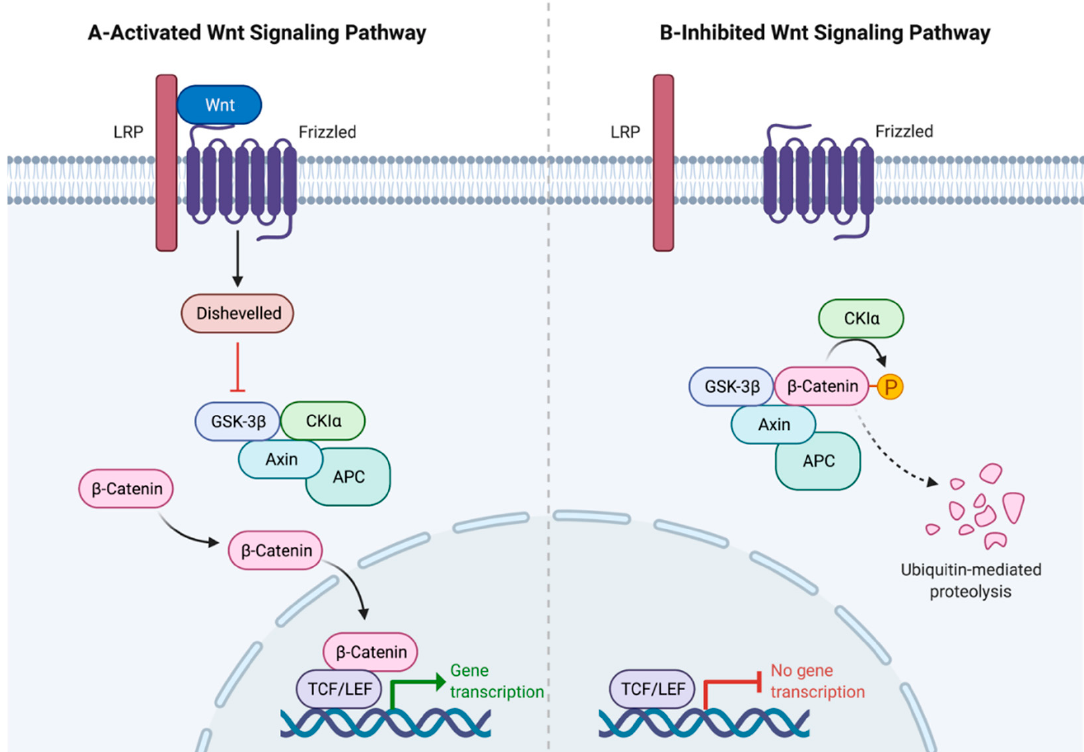
Figure 1. Wnt/ β -catenin signalling pathways. ( A ) Canonical Wnt signalling. Wnt ligands bind to FZD/LRP5/6 receptors, which leads to Dishevelled (Dvl) activation. This is followed by inhibition of the destruction complex Axin/APC/GSK-3 β /CKI, and the degradation of β -catenin is stopped, resulting in the accumulation and stabilisation of β -catenin in the cytoplasm. After accumulation, β -catenin enters the nucleus and interacts with LEF/TCF DNA-binding transcription factors. This results in the activation of Wnt target genes. ( B ) Canonical Wnt signalling (without Wnt binding). The destruction complex mediates β -catenin degradation through proteasomal machinery, leading to the association of LEF/TCF transcription factors with transcriptional corepressors in the nucleus,